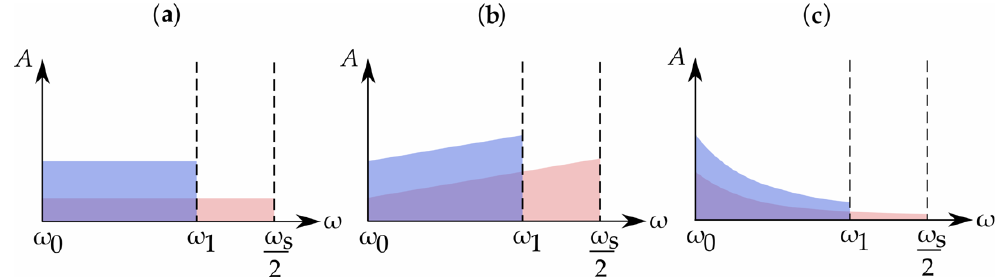
Figure 2. Illustration of Theorem 2. Blue plot corresponds to the Fourier transform of the signal 𝑈(𝜔) and red plot corresponds to the Fourier transform of the noise Ξ(𝜔) . ( a ) Original signal and noise; ( b ) after differentiation; and ( c ) after integration.